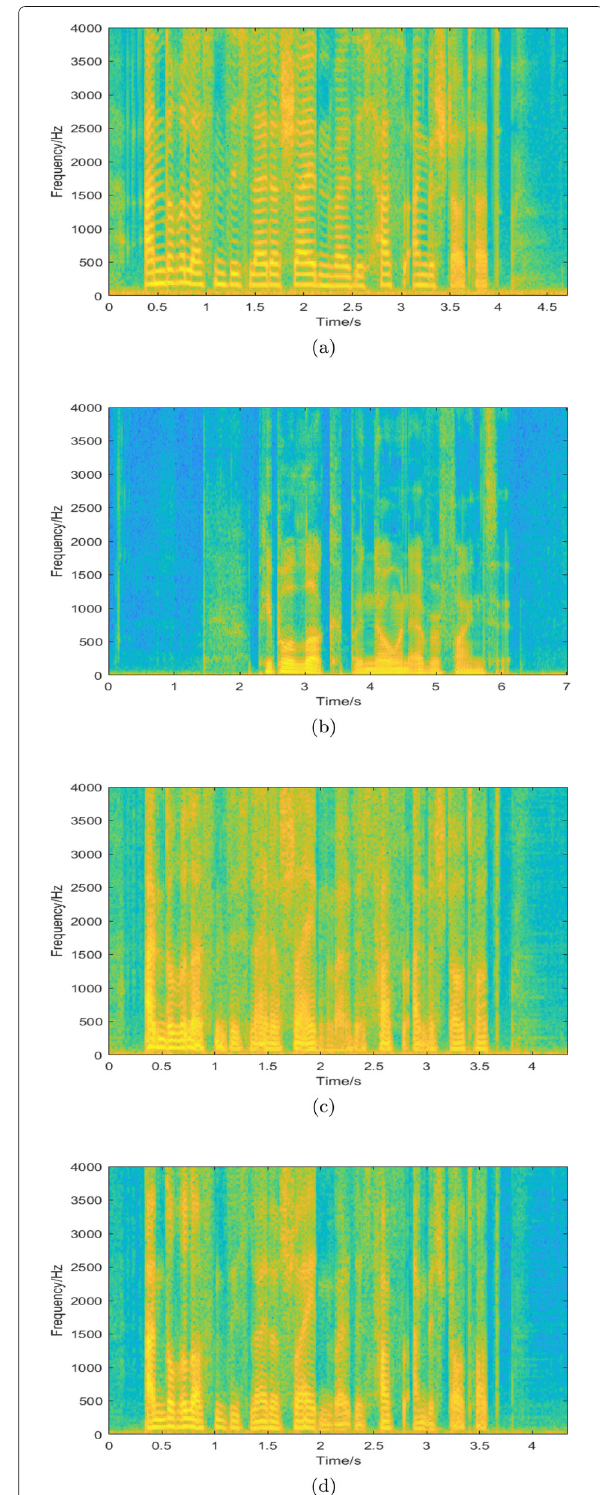
Fig. 6 Comparison among source, target, and the converted spectrograms in cross-lingual scenario(VCC2VCTK). a Source speech. b Target speech. c The converted speech of AGAIN-VC. d